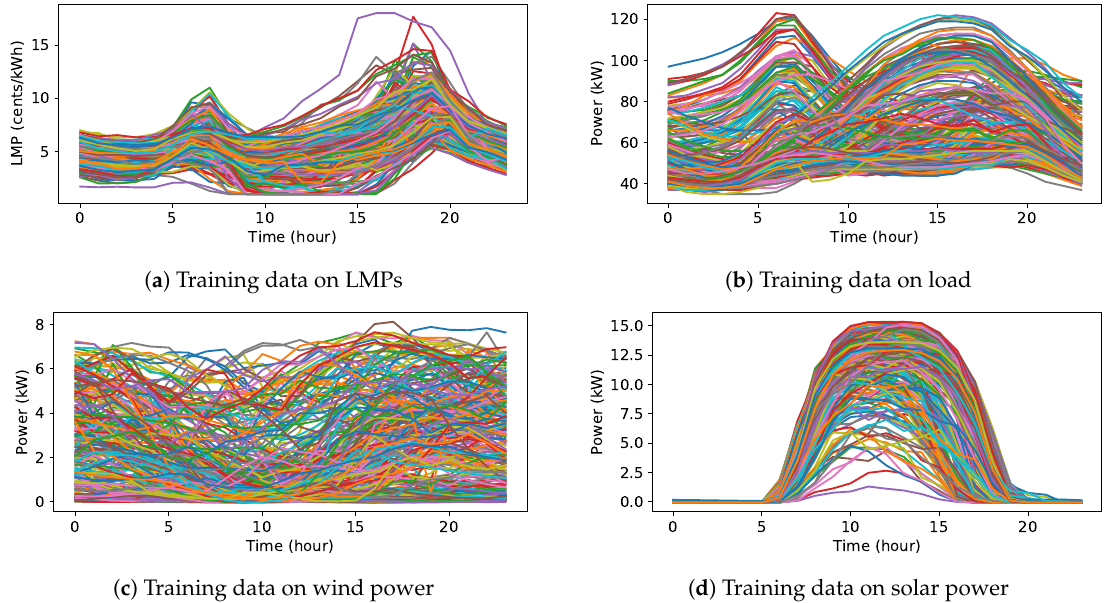
Figure 5. Training data used in the experiment 2. There are 252 days of hourly data in total.